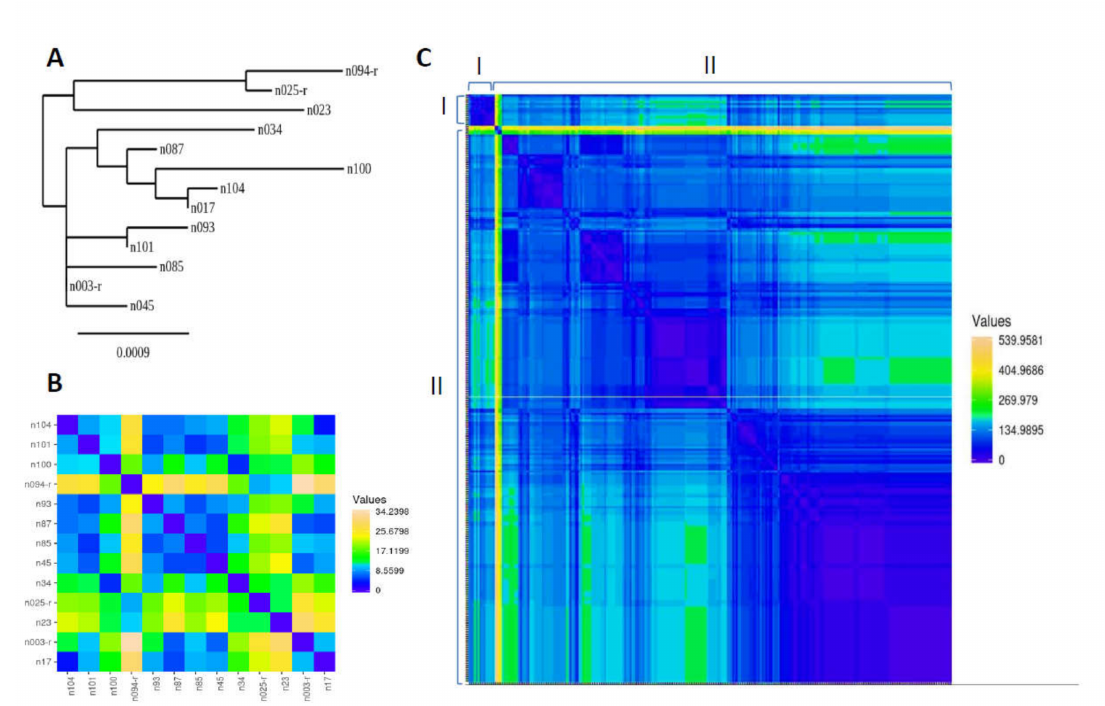
Figure 2. Genetic analysis of spike gene sequences isolated from slaughterhouse camels in Riyadh, 2019. ( A ): Phylogenetic tree based on nucleotide sequences of spike gene of the 13 isolates of this study. ( B ): Pairwise heatmap presentation of the 13 sequences ( C ): Heatmap to compare between MERS-CoV spike gene sequences obtained from (I) the current study ( n = 13) and (II) archived sequences obtained from GenBank ( n = 250). The color scale is shown to indicate the distance value between